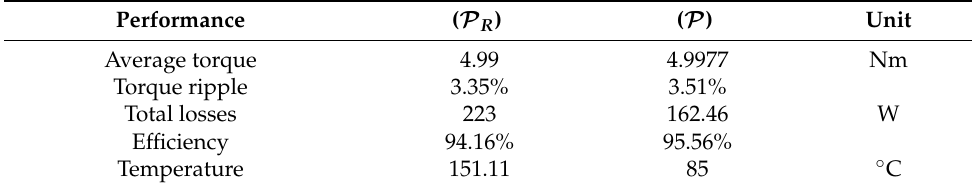
Table 4. Optimized machine